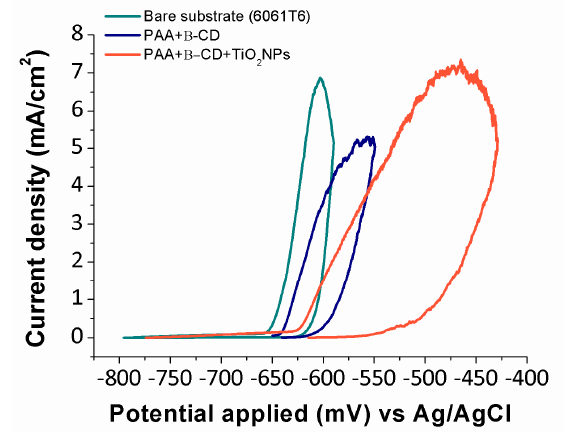
Figure 15. Cyclic polarization curves in 3.5% NaCl solution of aluminium bare substrate (black line), crosslinked PAA + β -CD electrospun fibres (blue line) and crosslinked electrospun fibres with metal oxide nanoparticles (PAA + β -CD + TiO2NPs) (orange line). Reprinted with permission of [53].